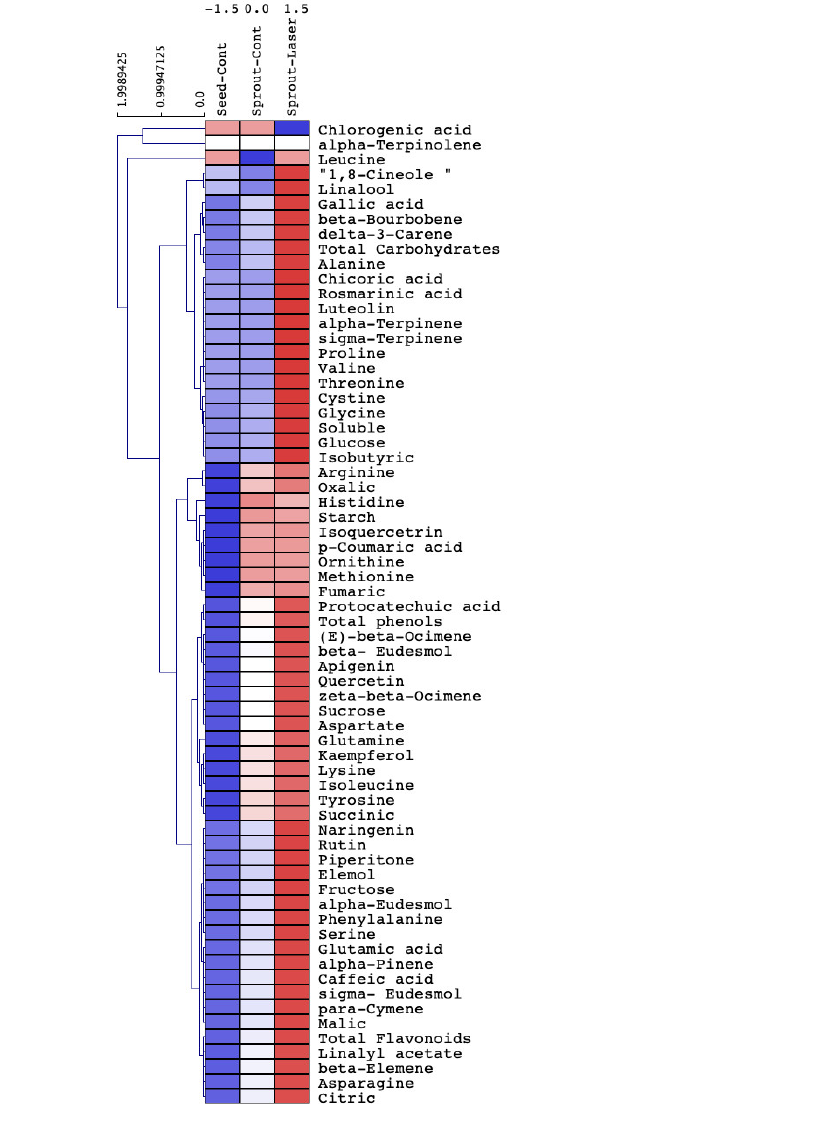
Figure 4. Heatmap showing the effect of He-Ne laser light treatment on growth, photosynthesis, respiration, metabolites, and biological activity of Cymbopogon proximus sprouts and